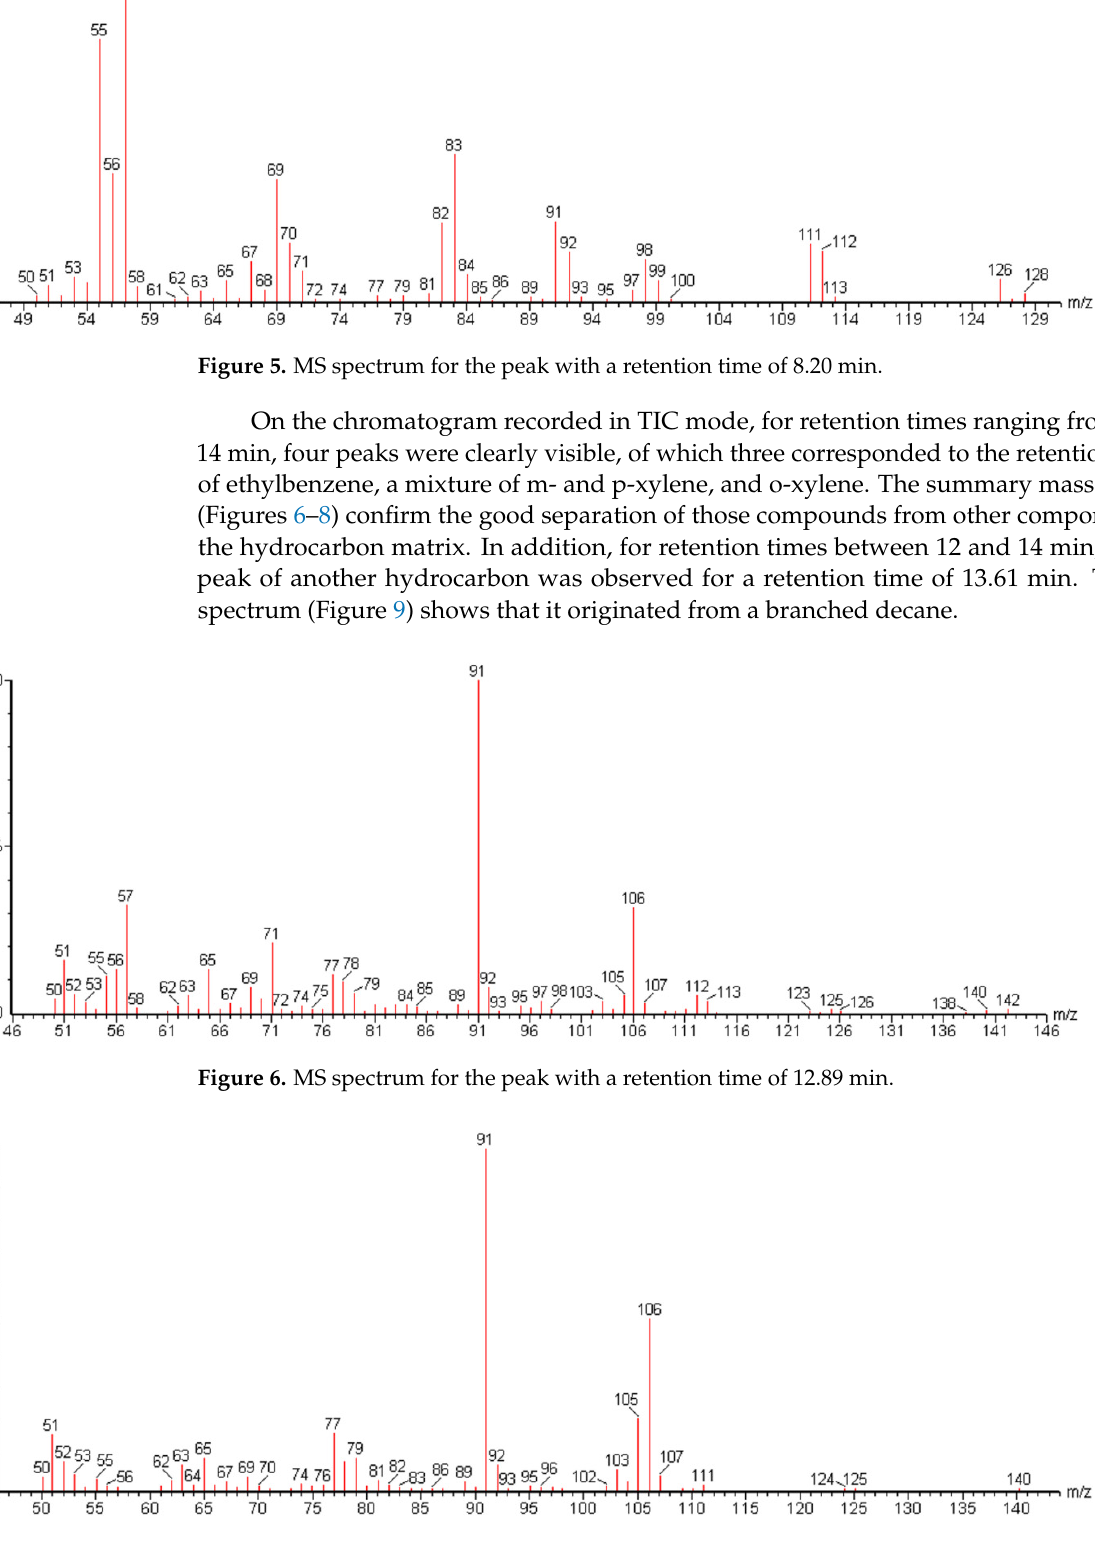
Figure 7. MS spectrum for the peak with a retention time of 13.04 min.